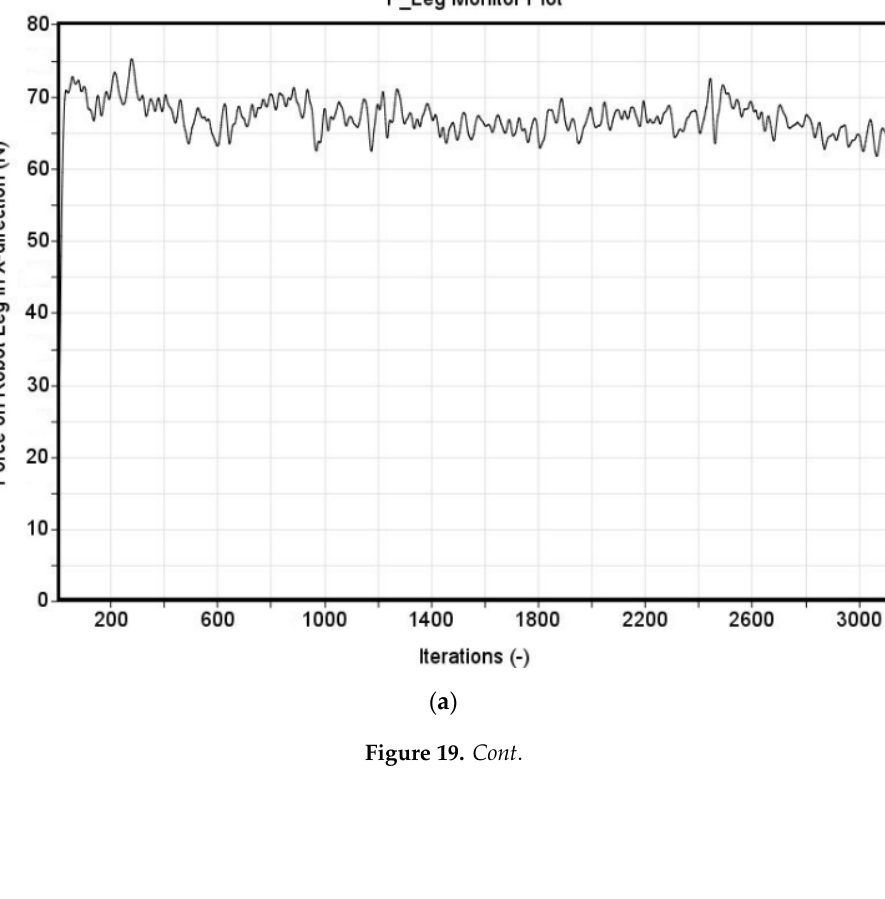
( b ) Figure 19. Drag force evaluation on ( a ) leg. ( b ) Robot body. A two-coordinate system is used for UMSWR, according to the Society of Naval Architects and Marine Engineers (SNAME) conventions (1950) [61]. These coordinates are the inertial frame of reference and body center called the body frame of reference, as shown in Figure 20.